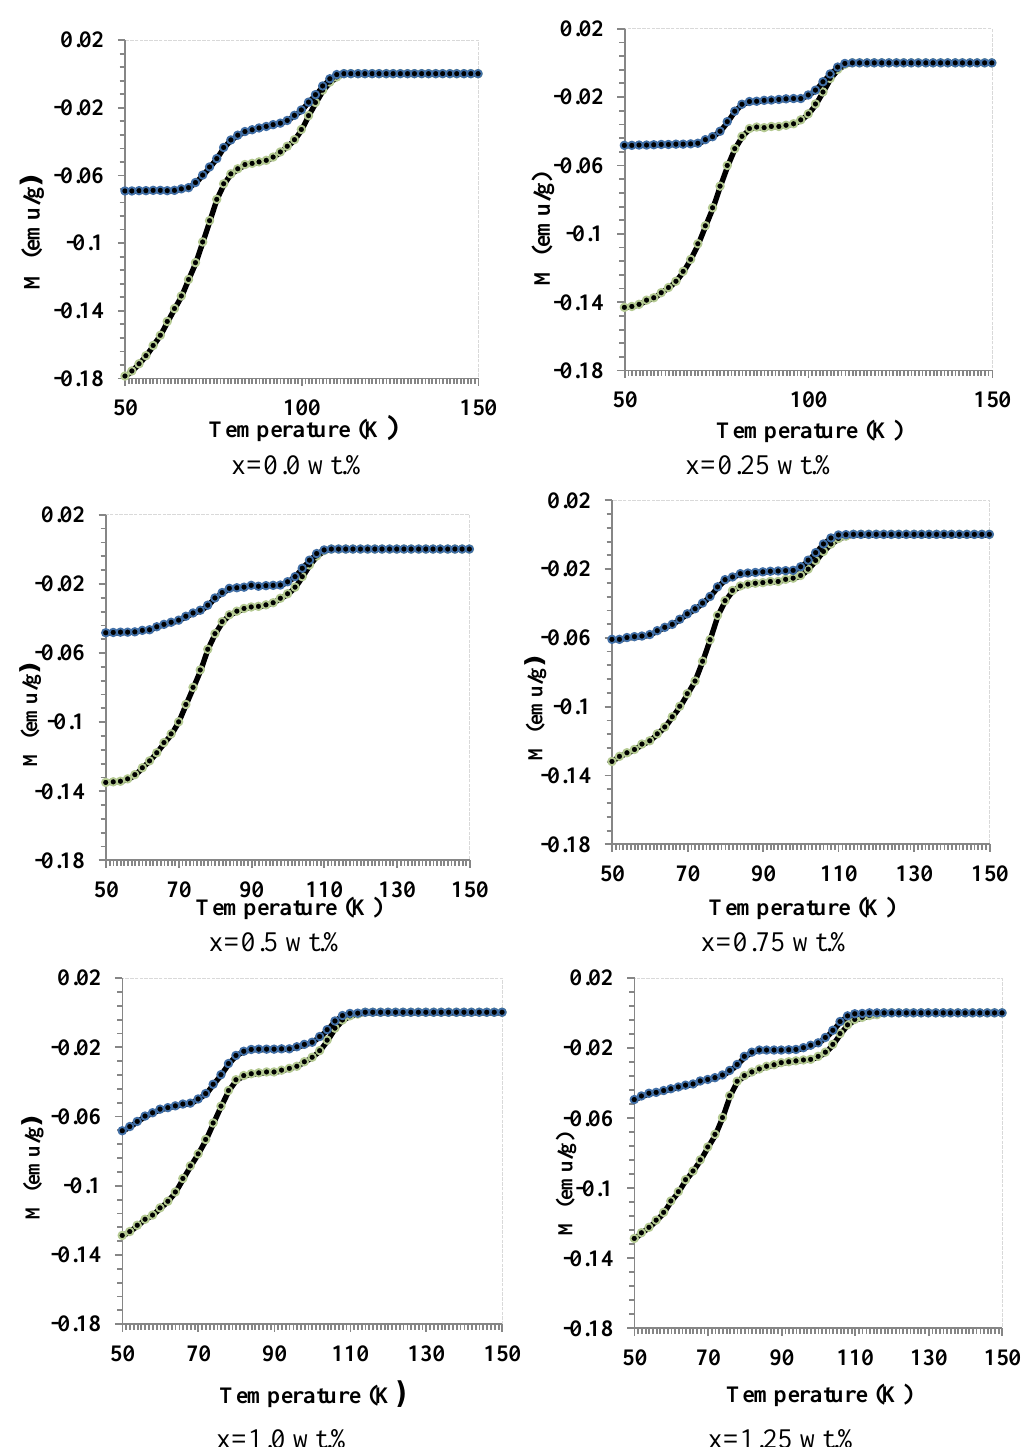
Fig. 7: M–T dependences of (Au) measured in zero-field cooled (ZFC) and field cooled